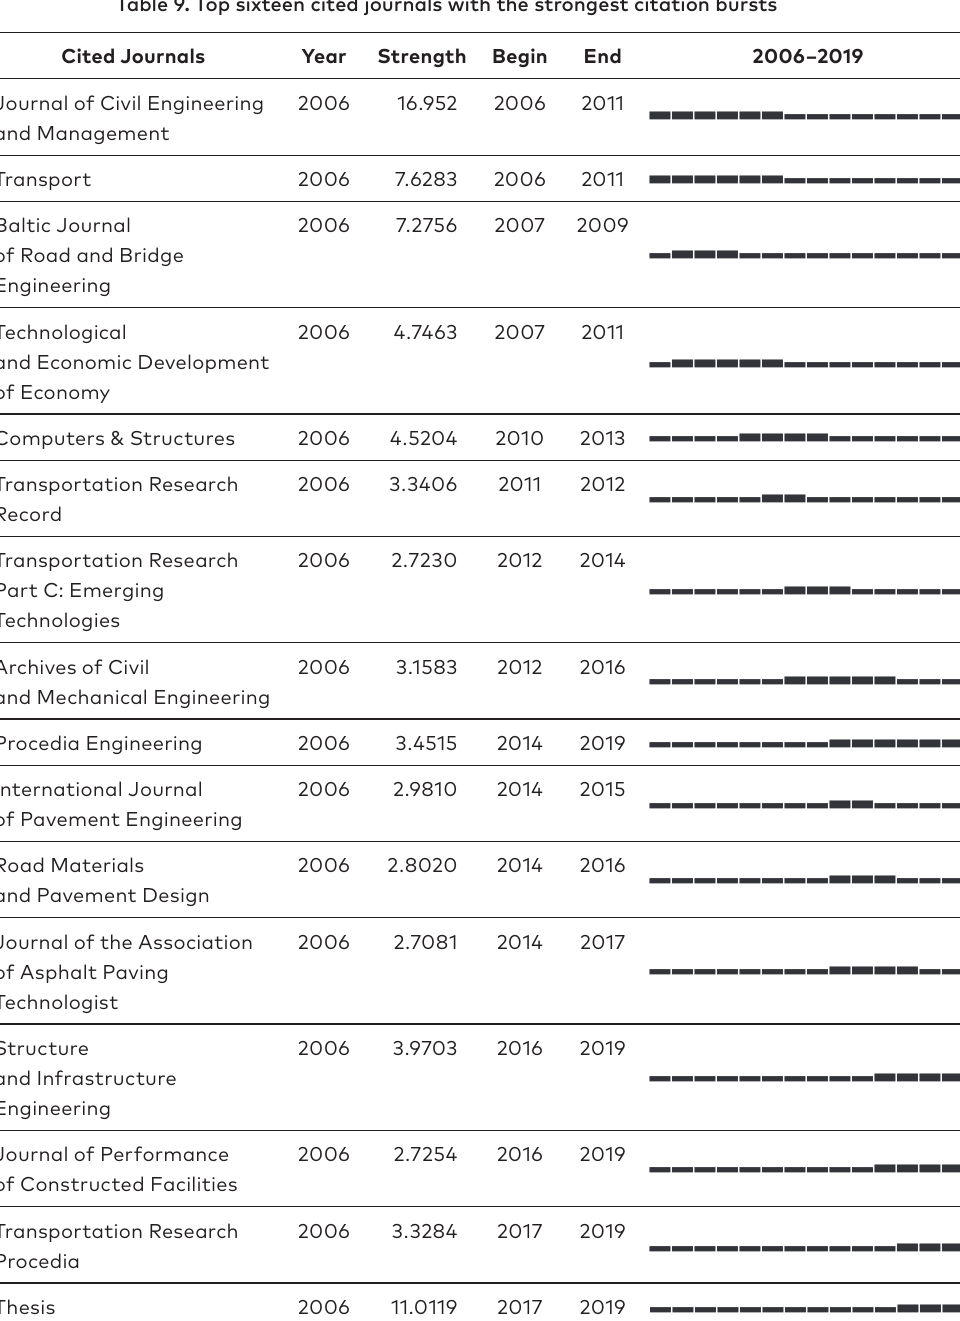
Figure 9. All keyword co-occurrence network of the Baltic Journal of Road and Bridge Engineering publications The top 16 cited journals with the strongest citation bursts by BJRBE are listed in Table 9. The first cited journal with the strongest citation burst is Journal of Civil Engineering and Management, and it began in 2006 and end in 2011. Journal of Civil Engineering and Management focuses on many areas of civil engineering and management. It aims to provide a multidisciplinary forum for researchers, designers, users, and manufacturers of the field of civil engineering and management. Journal of Civil Engineering and Management also has the highest value of strength from 2006 to 2011, and it is far more than other journals. Journal of Civil Engineering and Management, Transport and Procedia Engineering have the most extended duration. Here, Transport is published by the Vilnius Gediminas Technical University, it devotes to research transportation science and technology, and Procedia Engineering is an open-access collection of conference proceedings published, with emphasis on civil, chemical, aerospace, mechanical and structural engineering issues. From the last two columns, the strongest citation bursts of Procedia Engineering, Structure and Infrastructure Engineering, Journal of Performance of Constructed Facilities, Transportation Research Procedia, and Thesis are continuing, so these five journals are still influential to BJRBE. 5. Keyword co-occurrence network and timeline view for the